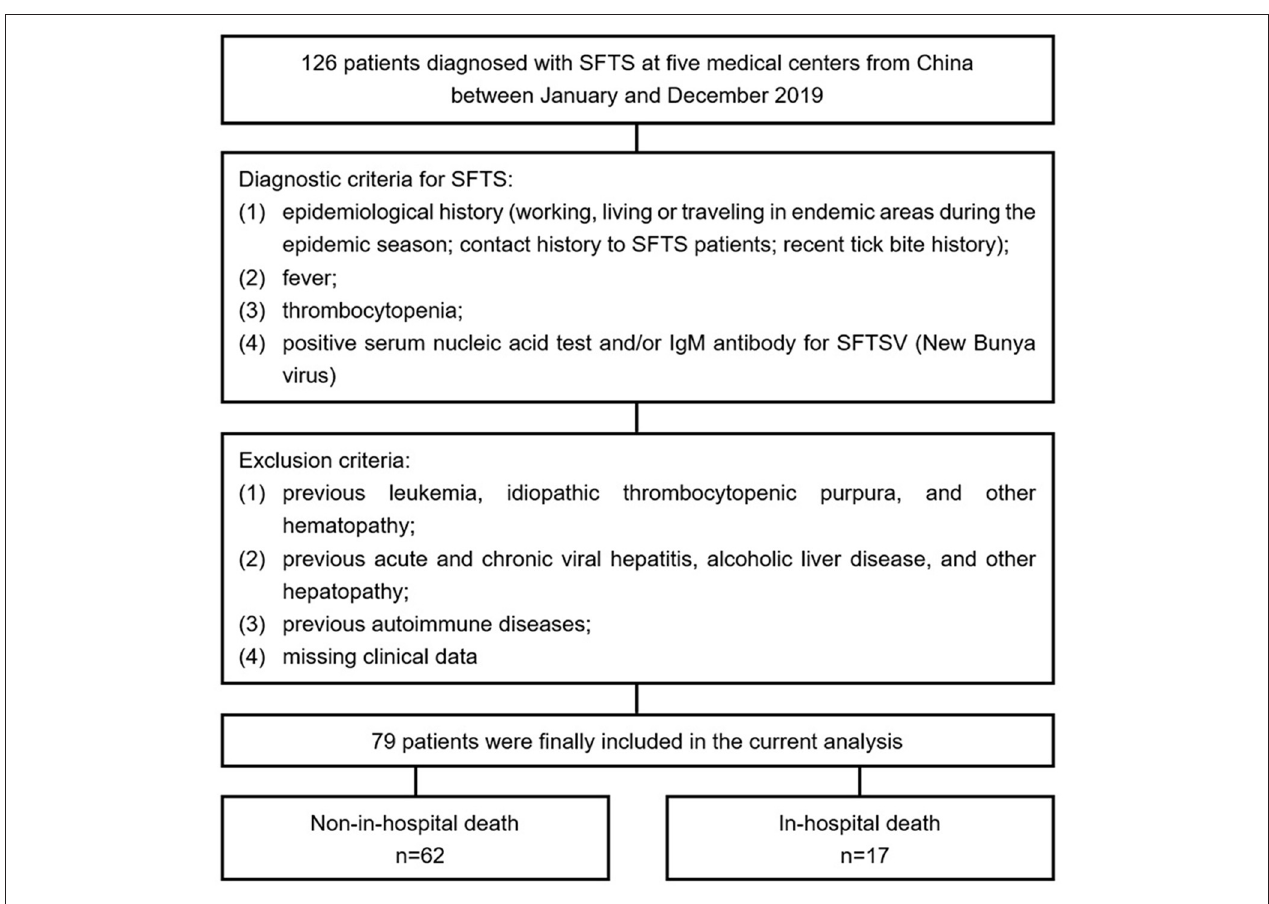
FIGURE 1 | Flow diagram for the enrollment of study population. SFTS, severe fever with thrombocytopenia syndrome; SFTSV, SFTS virus.